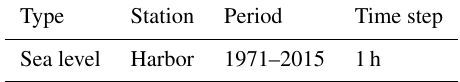
Table 1. Sea level and rainfall datasets.